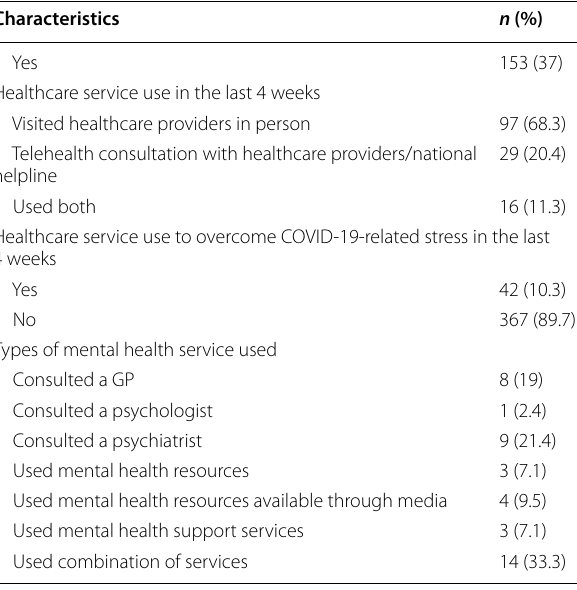
Table 1 Characteristics of the study sample in Kuwait ( N